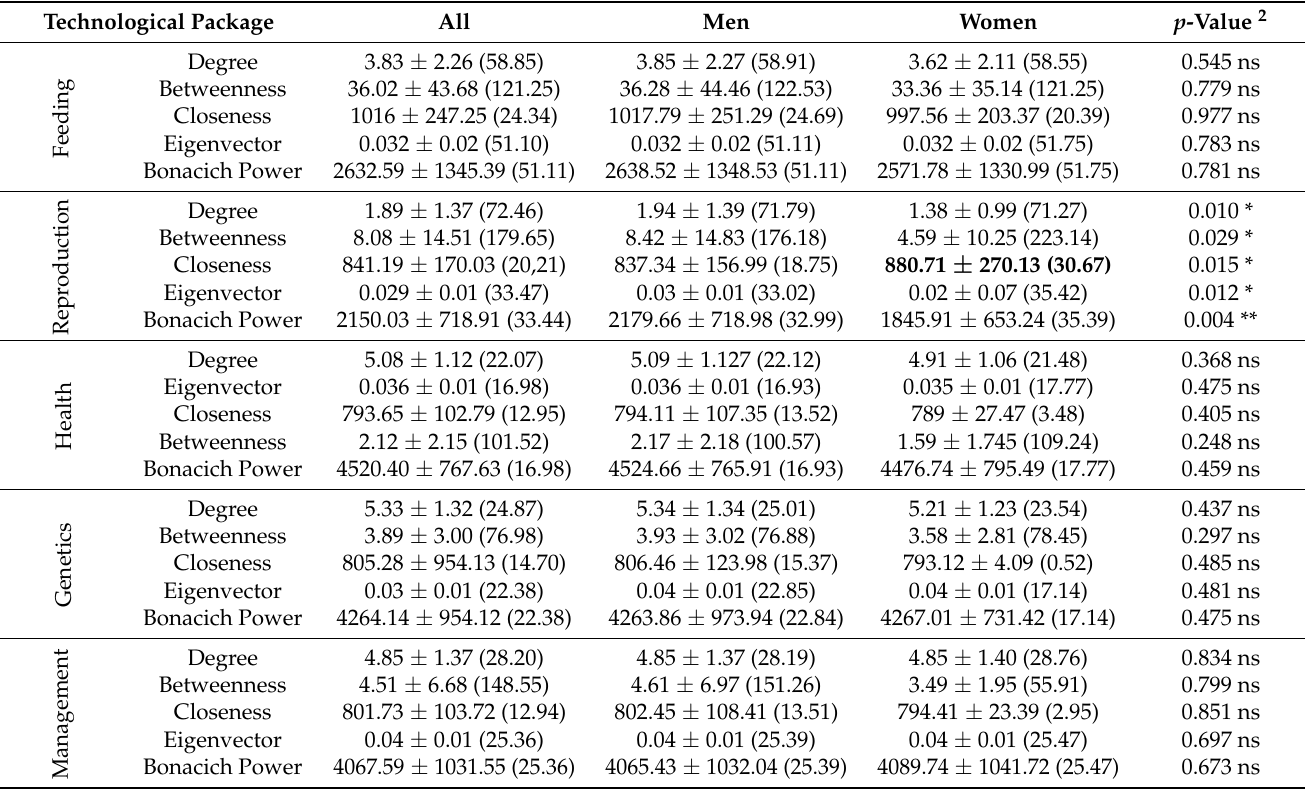
Table 5. Centrality measures descriptive statistics for technological packages (Mean ± SD (CV, %) 1 ) .